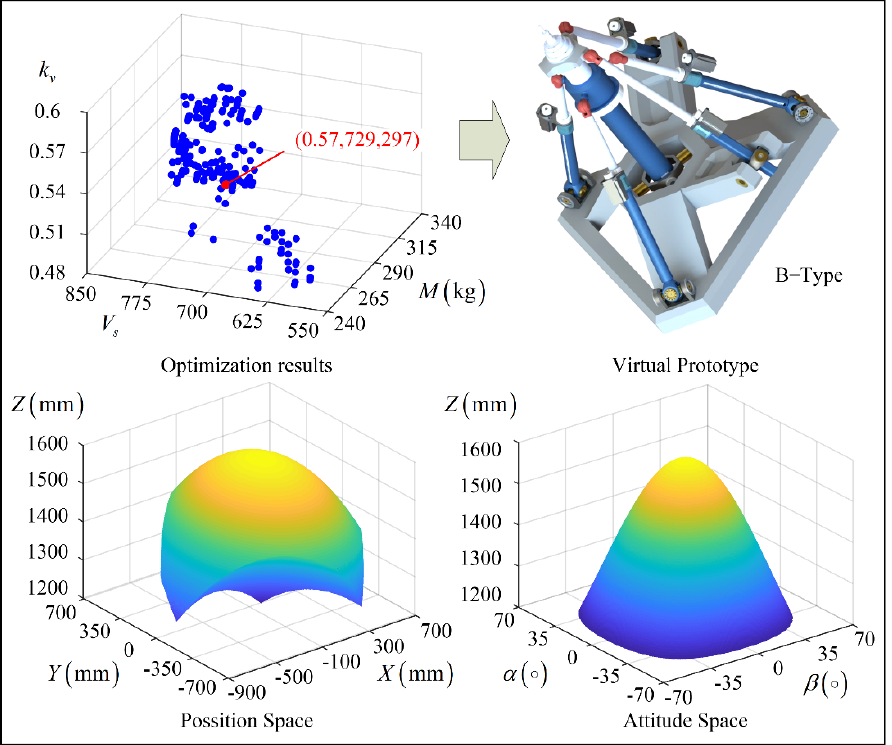
Figure 6. Result B.